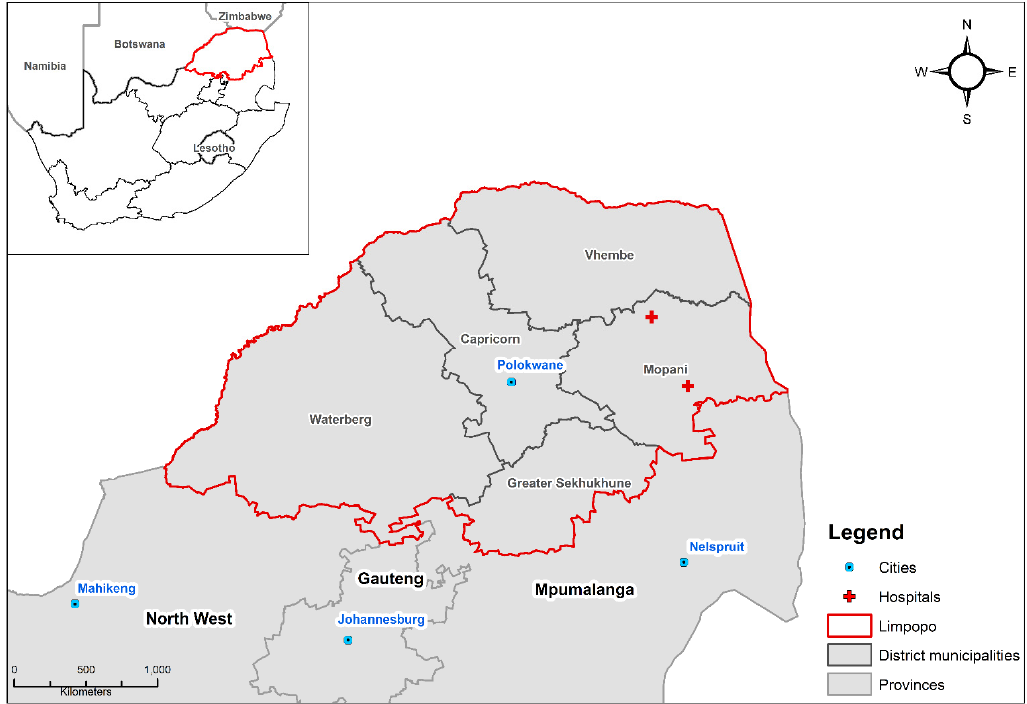
Figure 1. Location of the two hospitals in the study site of Mopani District, Limpopo province, South Africa.